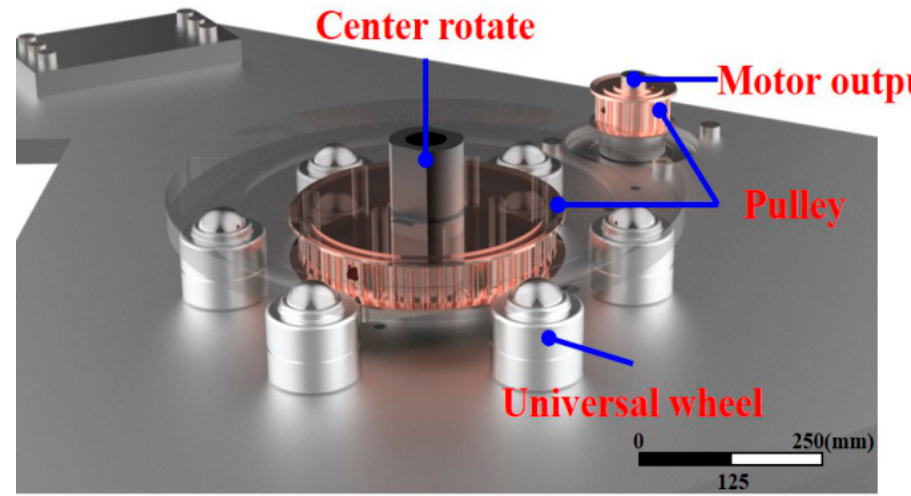
Figure 12. Central rotating mechanism.